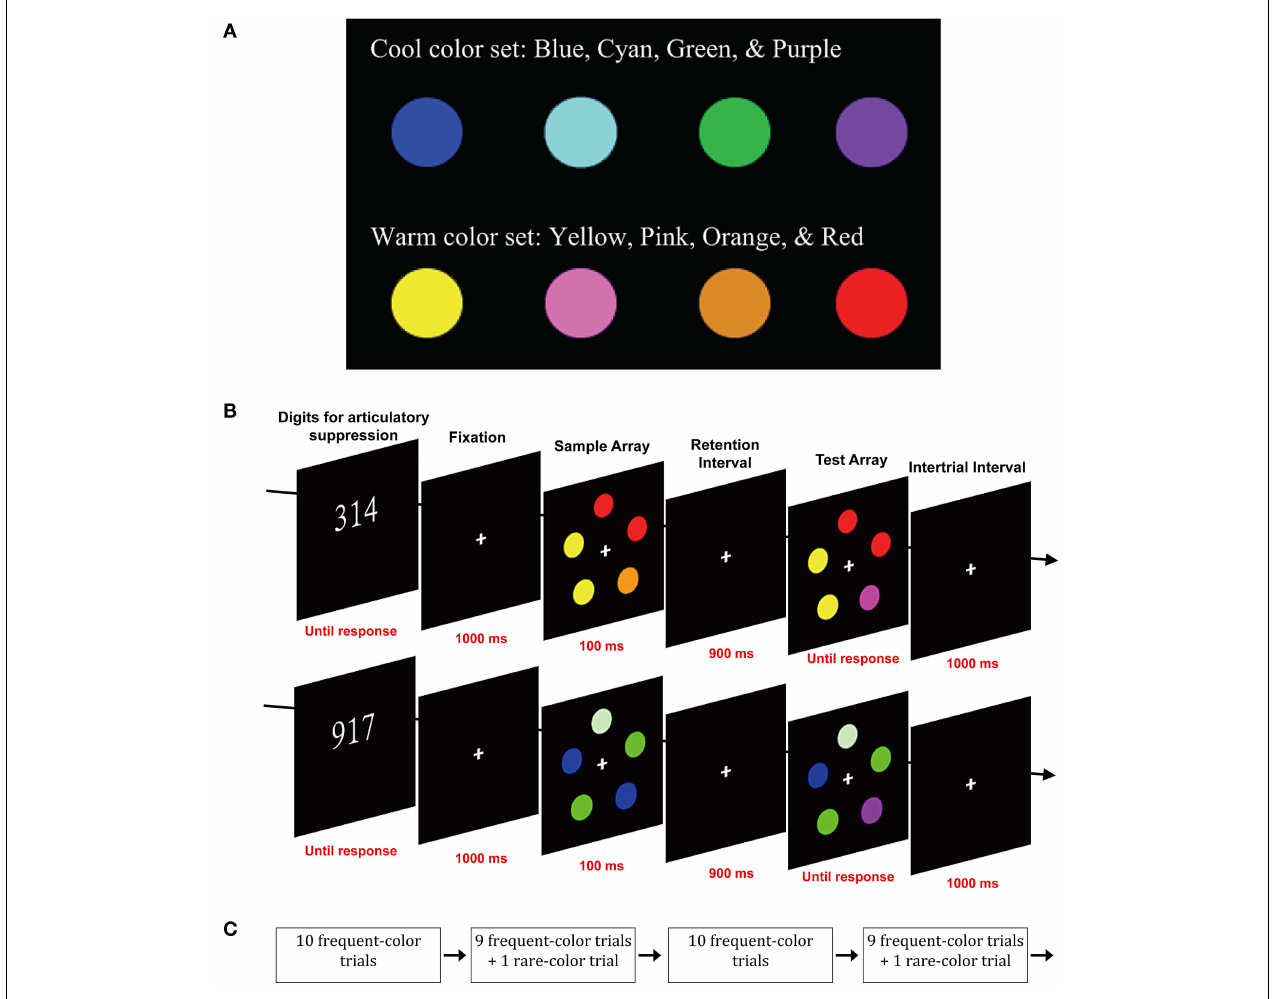
FIGURE 3 | Stimuli and design used in Experiment 2. (A) Cool and warm color sets. (B) Sequence of events on a typical single trial with each color set. (C) Method for ensuring that each trial using the rare color set was separated by 10–28 trials using the frequent color set.